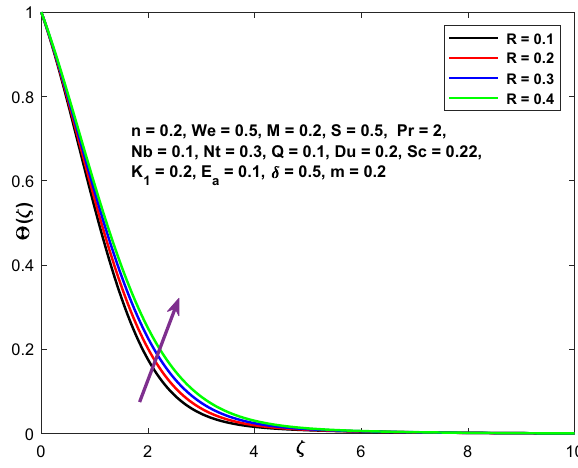
Figure 13. Character of R versus �(ζ) .